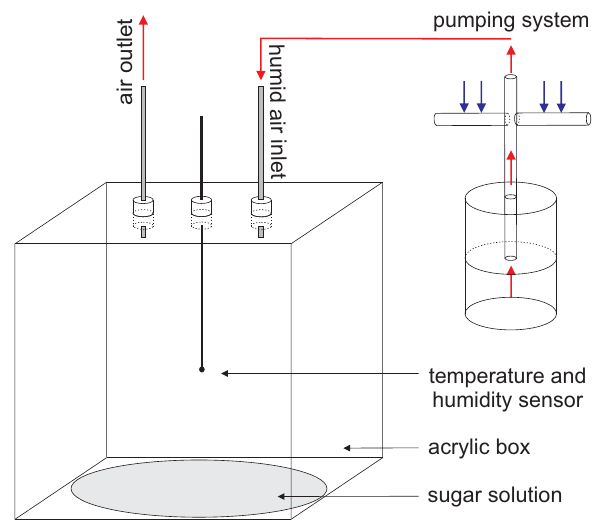
Fig. 1. General scheme of the cloud